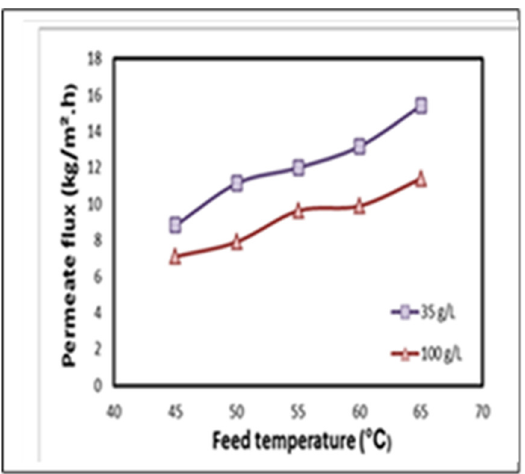
Fig. 4. the impact of feeding temperature on the resulting flux at various concentrations and 1.07 L/min feed flow rate.